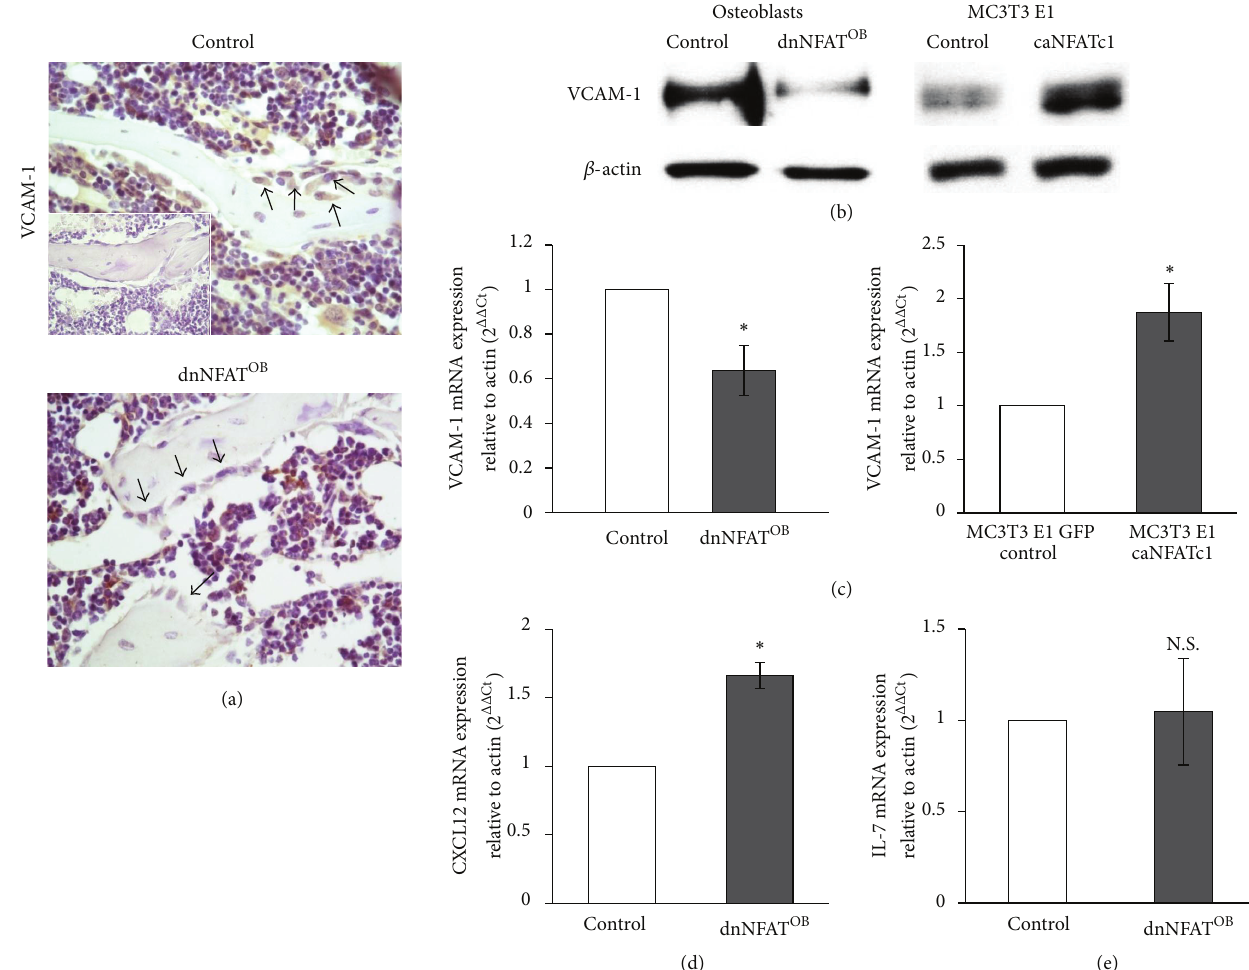
Figure 5: NFAT activation in osteoblasts positively controls VCAM-1 expression. (a) Tibiae were harvested from 12-week-old mice and examined by immunohistochemistry with anti-VCAM-1 ( brown ) and counterstained with hematoxylin ( blue ). Negative control staining was performed by using normal rabbit IgG instead of primary antibody ( top panel inset ). Magnification, 400x. (b-c) Primary osteoblasts were harvested from calvariae of 1-day-old control and dnNFAT OB mice and differentiated for 14 days in the presence of 𝛽 -glycerophosphate and ascorbic acid-2-phosphate to induce osteoblast differentiation. GFP control and ca-NFATc1-expressing MC3T3 E1 cells were cultured for 4 days. (b) Proteins were extracted from control and dnNFAT OB differentiated primary osteoblasts, GFP control, and ca-NFATc1 MC3T3 E1 cells and separated by SDS-PAGE. Immunoblots were developed using antibodies against VCAM-1 and 𝛽 -actin. Immunoblots are representative of three independent experiments. (c–e) RNA was extracted from control and dnNFAT OB differentiated primary osteoblasts ((c), left panel ) and GFP control and ca-NFATc1 MC3T3 E1 cells ((c), right panel ), and real-time PCR was performed for (c) VCAM-1, (d) CXCL12, and (e) IL-7 and 𝛽 -actin expression. Values were obtained from three independent experiments and represent the mean ± SD of VCAM-1, CXCL12, or IL-7 levels relative to 𝛽 -actin; ∗ 𝑃 < 0.05 compared to